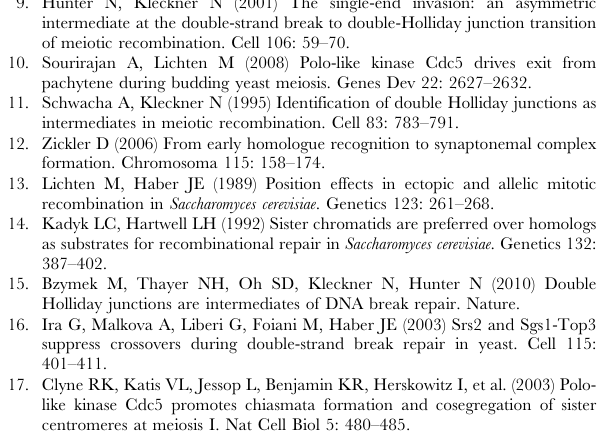
Figure S1 Expected outcomes if DNA replication occurs (a) or does not occur (b) before the first nuclear division after RTG. One homolog is shown as solid line and the other as dashed line. Black and diagonal hatched boxes indicate MAT a and MAT a alleles, respectively. After 7 hr in meiosis (left in a and b), each cell contains two copies of each MAT allele. a. Replication followed by equational chromosome segregation results in two copies of each MAT allele in each daughter cell. Sporulation of these cells produces MAT a/ MAT a nonmater, MAT a/ MAT a mater and MAT a / MAT a mater diploid cells. b. Equational chromosome segregation without prior replication leaves one copy of each allele. Sporulation of these cells produces only haploid mater cells. See text for details. (TIF) Figure S2 JM resolution after RTG in an ndt80 D diploid cells (MJL3164). After 7 hr in sporulation medium, cells were shifted to YPD to undergo RTG. 0 hr – time of shift to YPD. See Figure 4 for digest and probe details. a. JM intermediates. Left: blots of Xmn I digests probed with ARG4 sequences. Right: JM frequencies, plotted as a percent of total lane signal. b. COs. Left: blots of Xho I digests probed with ARG4 sequences. Right: CO2 frequencies plotted as a percent of total lane signal. c. NCOs. Left: blots of Xho I /Eco RI digests probed with HIS4 sequences. Right: NCO frequencies plotted as a percent of total lane signal. (TIF) Table S1 Strains used in this work. All are MAT a / MAT a lys2/ lys2 ho::LYS2/ho::LYS2 . The ndt80 allele is ndt80 D (Eco47III- BseRI)::KanMX6 . MJL2984-derived strains contain the recombi- nation reporter illustrated in Figure